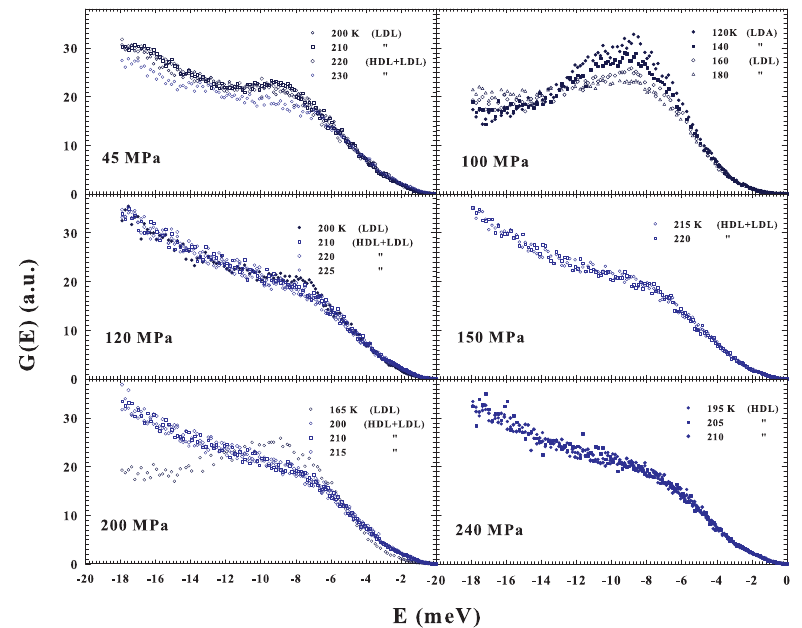
Figure 5. The DOS under different P – T conditions. For three cases, P = 45, 120 and 200 MPa, we observed the water crossover from a fragile to strong liquid (obtained by changing T ), whereas, in two other cases, P = 150 and 240 MPa, we studied, at different T , the supercooled liquid inside a precise phase: fragile and strong, respectively. Finally, in one case, P = 100 MPa, the data deal with a transition, obtained by decreasing T , from the low density liquid to the low density amorphous (LDL to